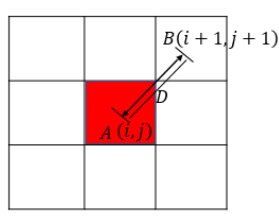
Figure 6. The calculation of fitness value with POI D is the distance between certain point and POI, the fitness value of the certain point is calculated according to equation 4, related to the distance D .